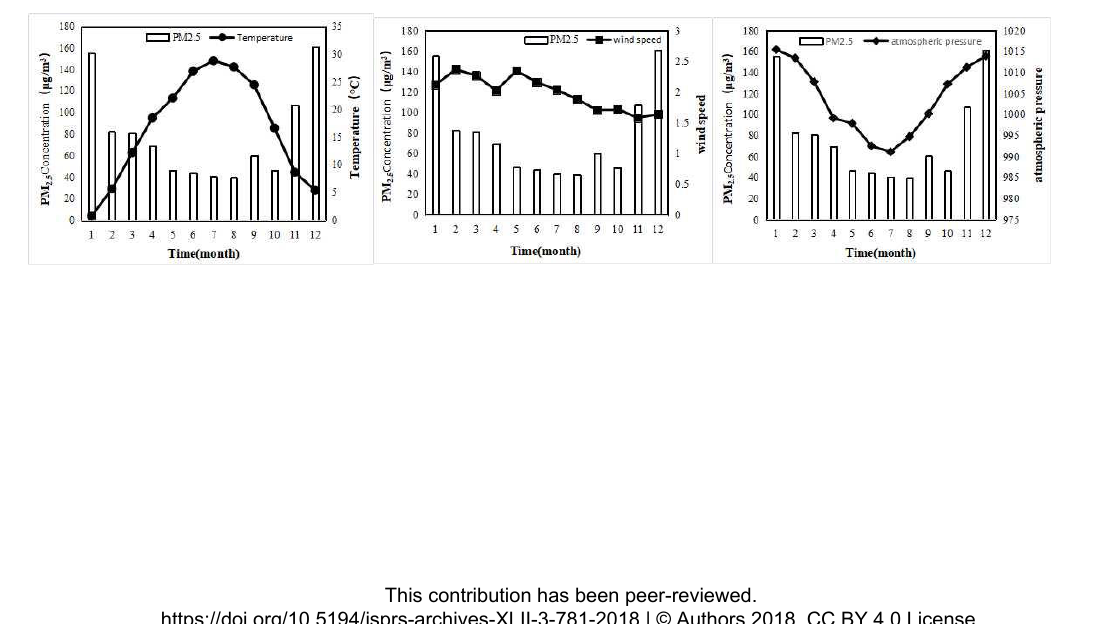
Table 1 Correlation between PM 2.5 and meteorological